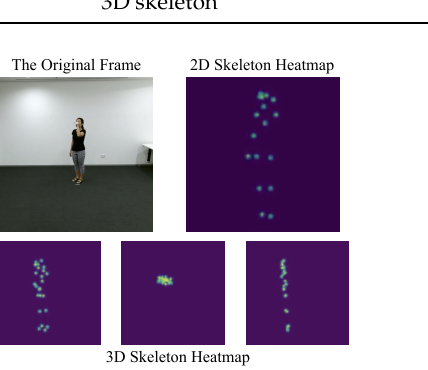
Figure 11. Examples of 2D skeleton consisting of 17 points and 3D skeletons reduced to 2D in dimen-